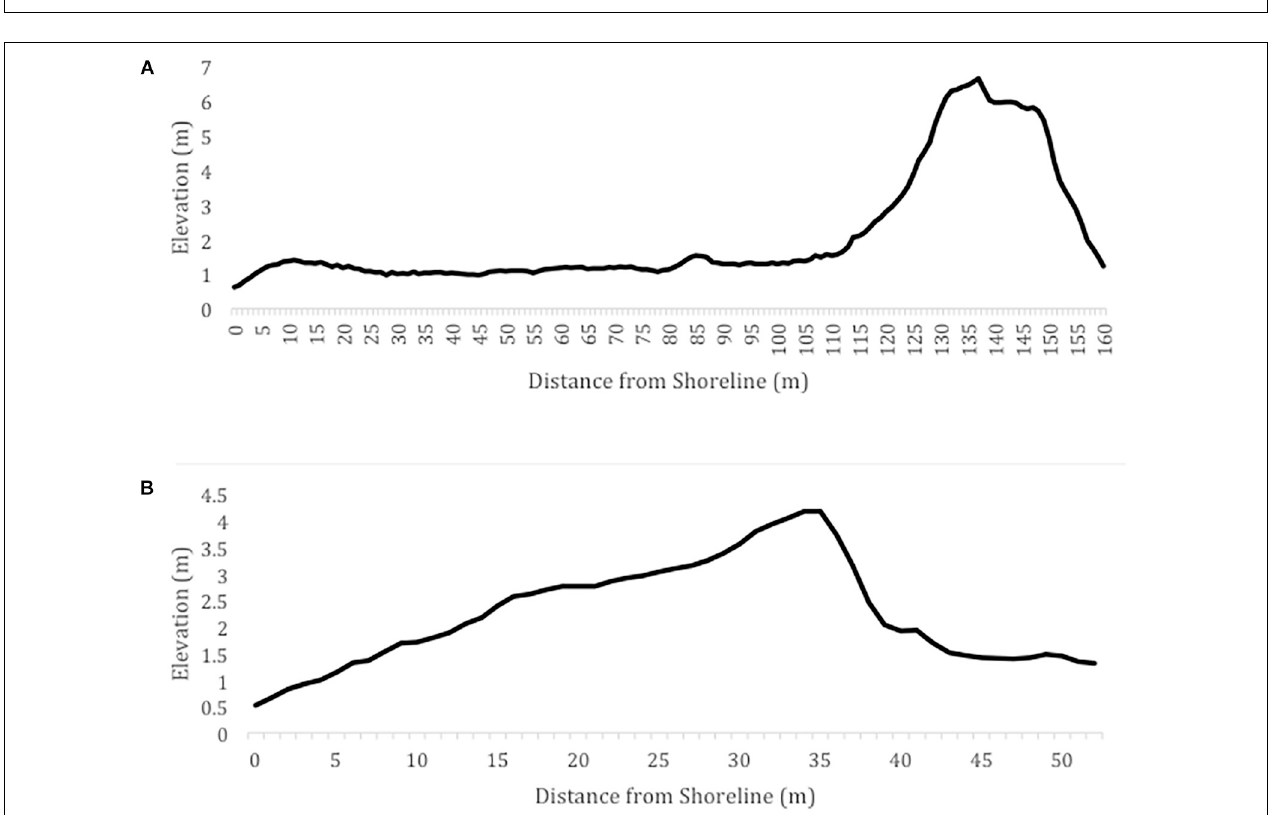
Frontiers in Marine Science |